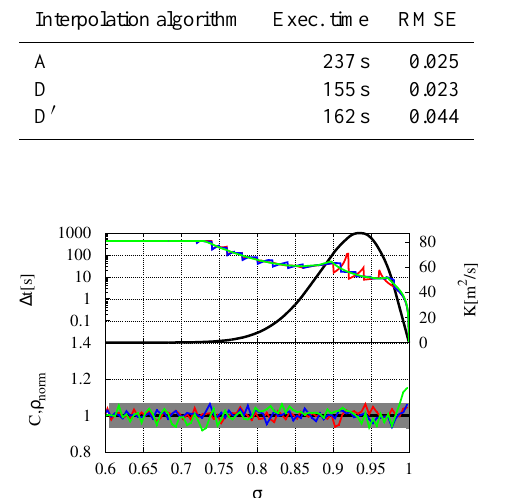
Table 2. Execution time and RMSE for experiments made with the sampled “average” diffusivity distribution and varying interpolation method.